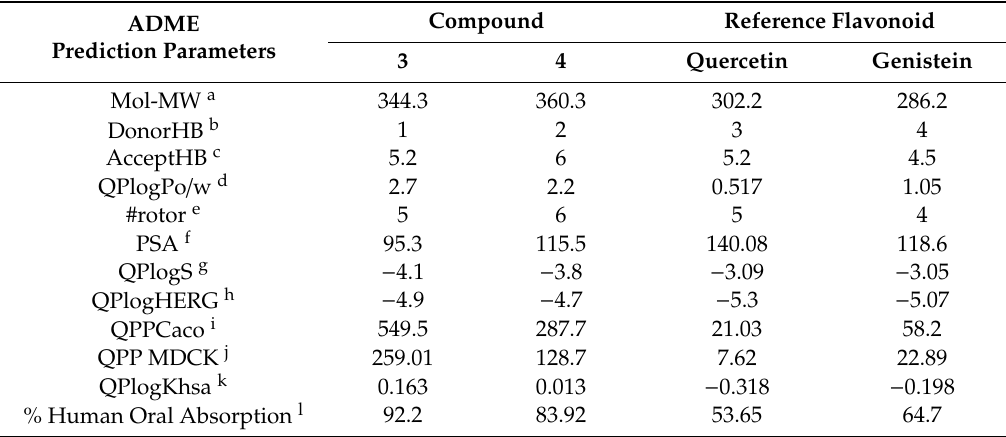
Table 2. In silico absorption, distribution, metabolism and excretion (ADME) prediction parameters of isolated and reference